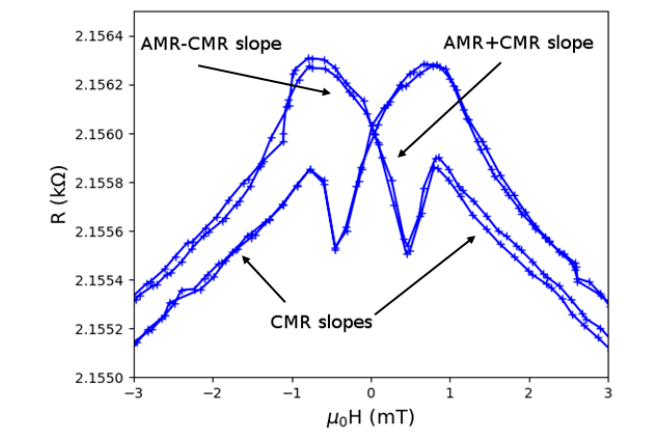
Figure 2. Electrical resistance of a 100 µm wide 300 µm long stripe patterned in a 50 nm thick LSMO film deposited on STO (001) and aligned at 45° with respect to the easy axis direction as a function of applied magnetic field at room